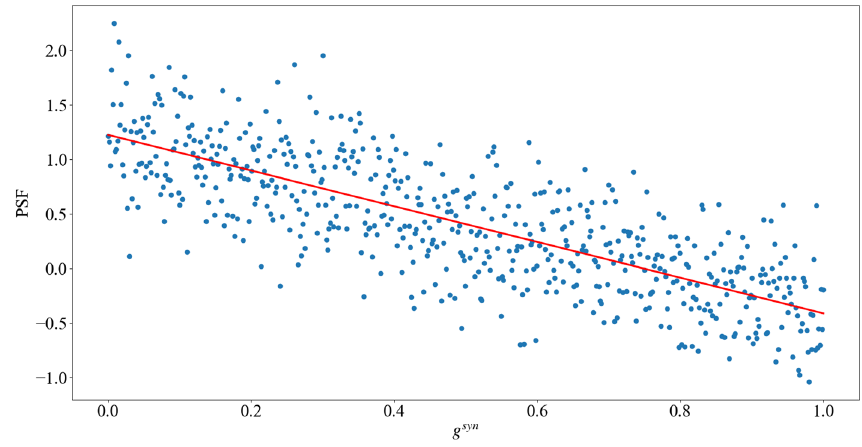
Figure 13. Synaptic strength on the change of PSF value.